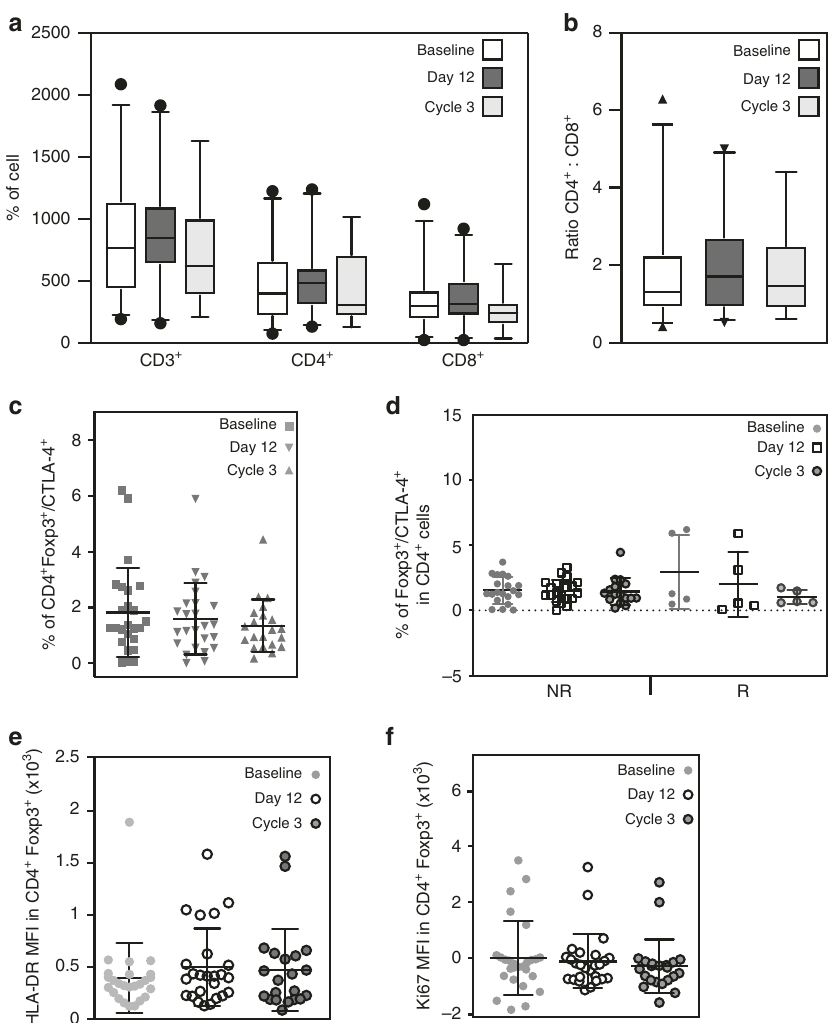
Fig. 5 Immune cell subsets evaluation in blood was not affected by the treatment. Quanti fi cation of CD3, CD4 and CD8 cells ( a ) and ratio of CD4:CD8 cells ( b ) before beginning of treatment (Baseline), on day 12 of Cycle 1 (Day 12) and at the end of Cycle 3 (Cycle 3) ( n = 25). The markers represent the 5 th percentile, fi rst quartile, median, third quartile, and 95 th percentile values, respectively ( a , b ). c Flow cytometry quanti fi cation of Foxp3 + CTLA-4 + CD4 + Tregs at baseline, on day 12 Cycle 1 (Day 12) and at the end of Cycle 3 for all patients ( n = 25). d Flow cytometry quanti fi cation of Foxp3 + CTLA-4 + CD4 + Tregs in blood obtained from all the patients with or without a response (R and NR respectively) before treatment (Baseline), on Cycle 1 day 12 and at the end of Cycle 3 ( n = 25). Flow cytometric quanti fi cation of HLA-DR ( e ) and Ki67 ( f ) expression in Foxp3 + CD4 + T-cells at baseline, on day 12 of Cycle 1 and at the end of Cycle 3 ( n = 25). Data are presented as the mean ± SD. No statistical signi fi cance was found in any of the panels, This was determined by one-way ANOVA for a (CD3) and c and Kruskal-Wallis test for a (CD4 and CD8), b , d – f